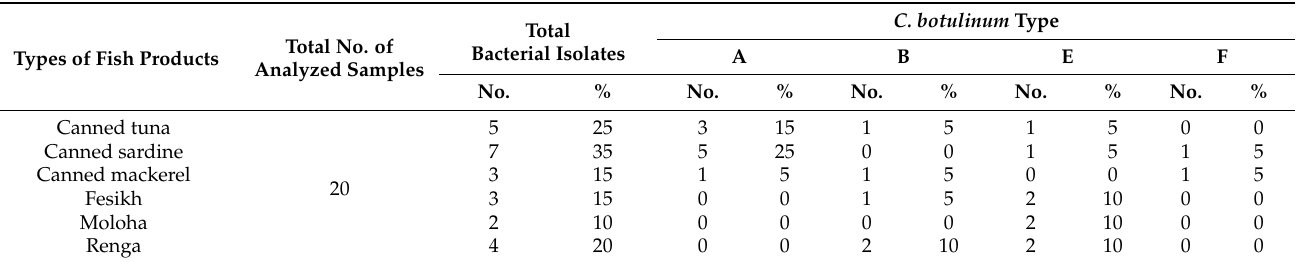
Table 1. Detection of C. botulinum types (A, B, E, and F) in fish product samples from the Alexandria governorate.